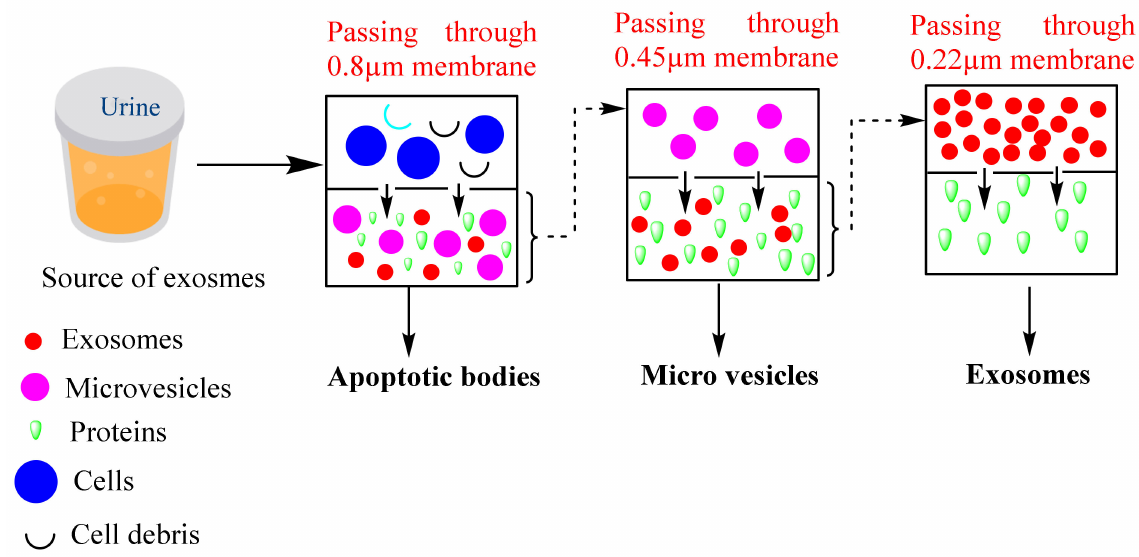
Figure 4. Common steps followed during the separation of exosomes via ultrafiltration. Here, the samples are passed through multiple membranes of different pore sizes such as 0.8, 0.45, 0.22 µ which result in the concentration of the sample after every pass through the filters of different pore